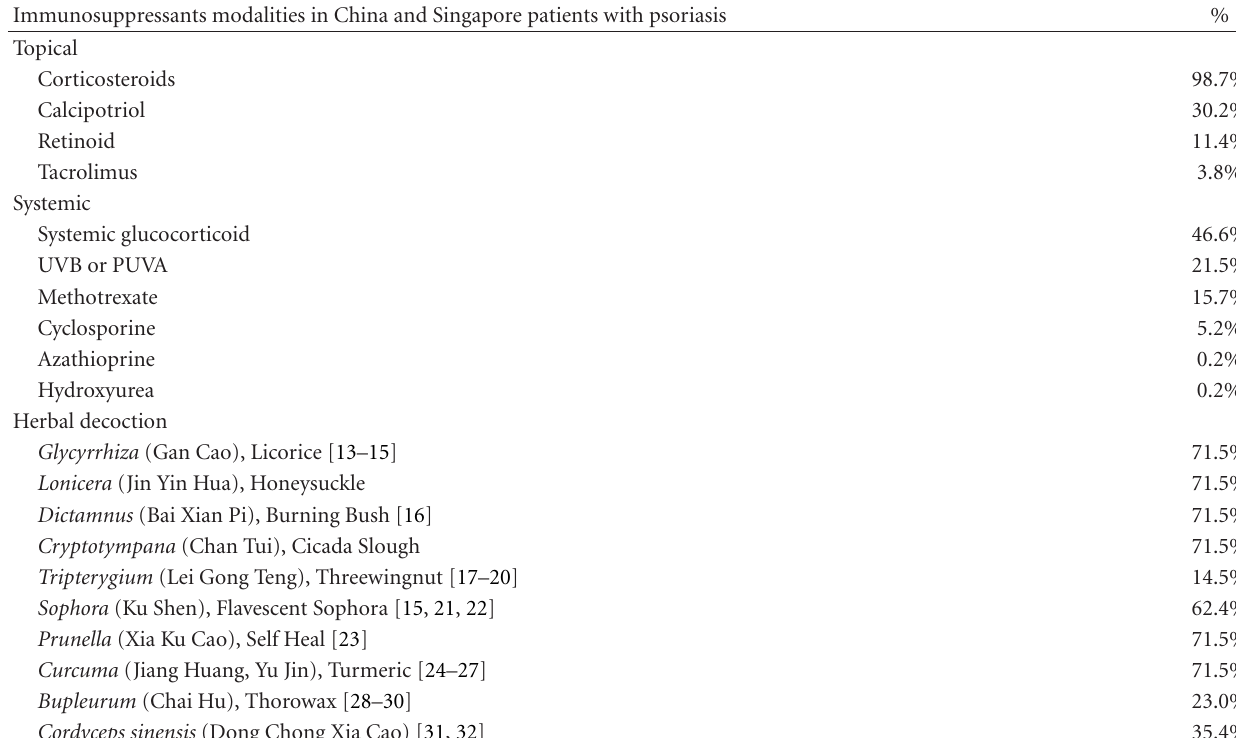
Table 3: Immunosuppressants modalities in China and Singapore patients with psoriasis. Immunosuppressants modalities in China and Singapore patients with